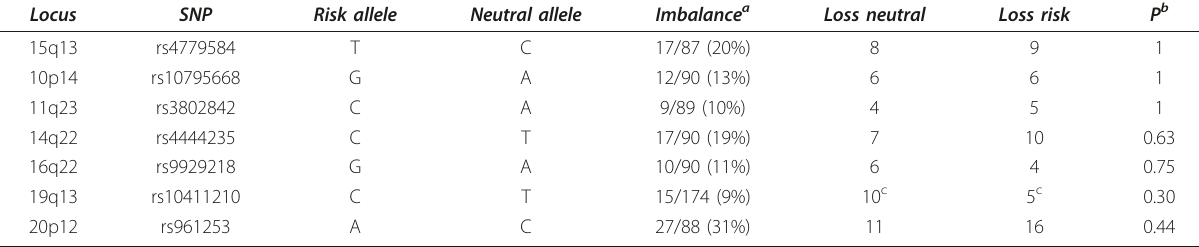
Table 2 Results of allelic imbalance analysis in low-penetrance CRC loci Locus SNP Risk allele Neutral allele Imbalance